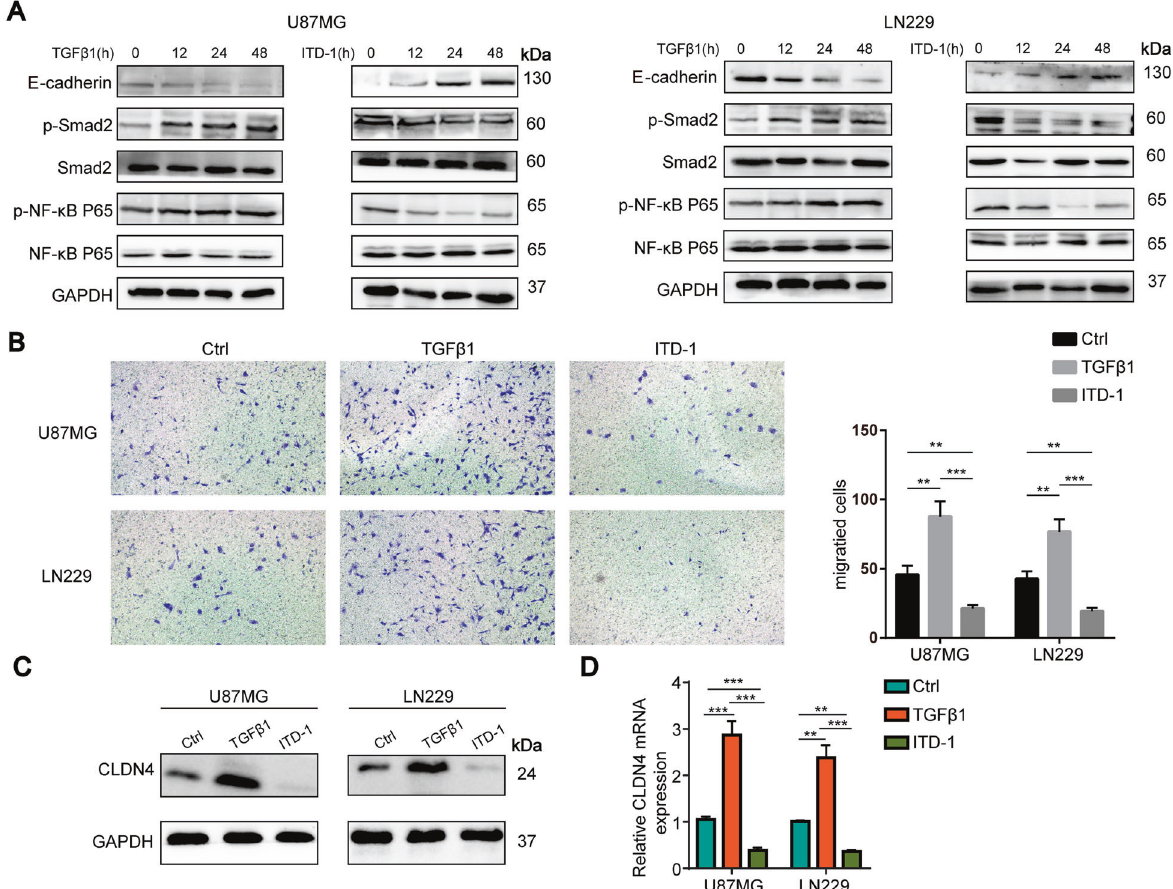
Fig. 5 TGF β 1 upregulates CLDN4 in GBM cells. A western blotting analysis of E-cadherin, p-Smad2, Smad2, p-NF- κ B P65, NF- κ B P65 expression in GBM cells after 0 h, 12 h, 24 h, 48 h treatment with TGF β 1 (10 ng·mL − 1) or ITD-1 (5uM). B The invasion ability of GBM cells was determined by Transwell assay (magni fi cation, ×200). C The CLDN4 expression was determined after treated with or without TGF β 1 (10 ng·mL − 1 ) or ITD-1 (5uM) by western blotting in GBMcells. D The CLDN4 expression was determined after treated with or without TGF β 1 (10 ng·mL − 1 ) or ITD-1 (5uM) by RT-qPCR in GBM cells. Representative images of three cases were shown. Data are represented as the mean ± standard deviation of three independent experiments. Student ’ s t -test, compared to the Control group. ** P < 0.01, *** P <